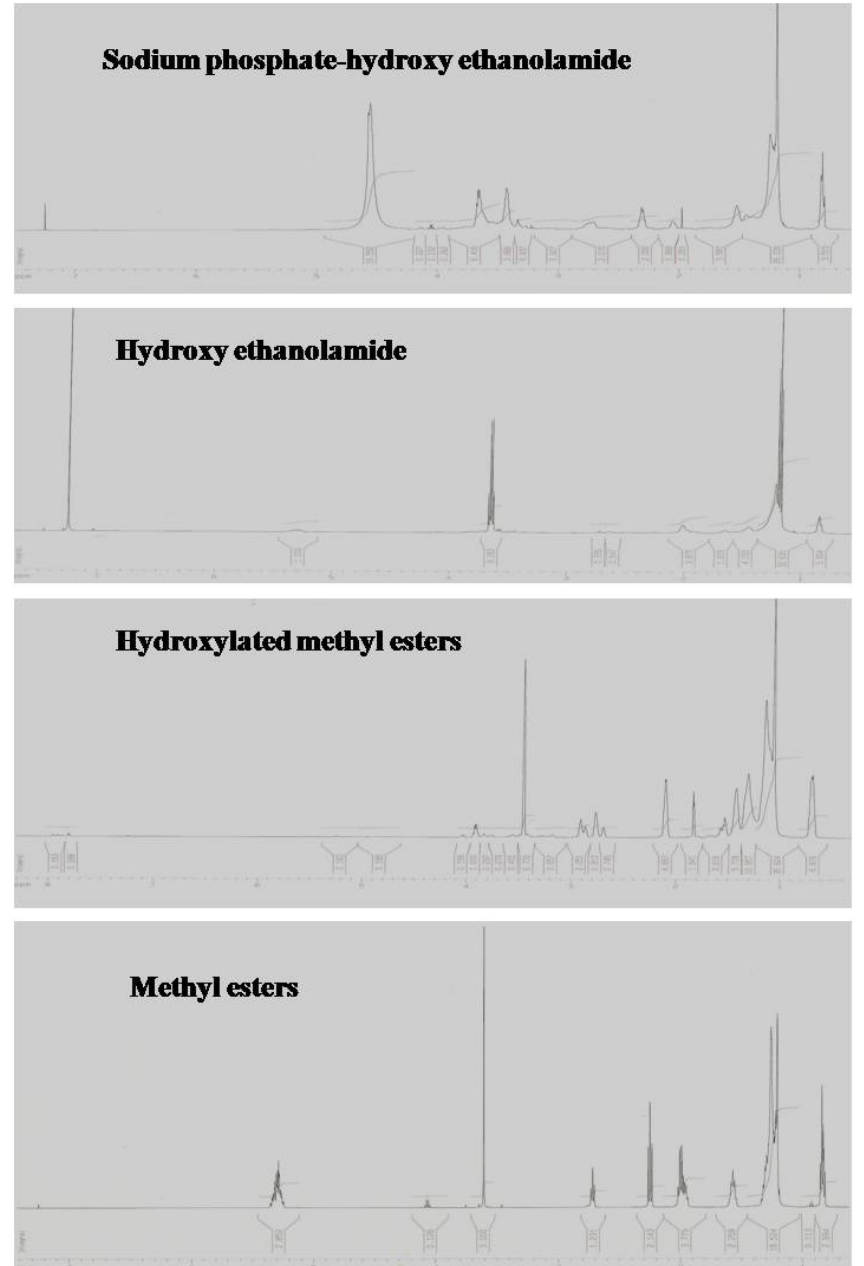
Figure 2. 1 HNMR spectra of the methyl esters, hydroxylated methyl esters, hydroxy ethanolamide and sodium phosphate-hydroxy ethanolamide of luffa cylindrica